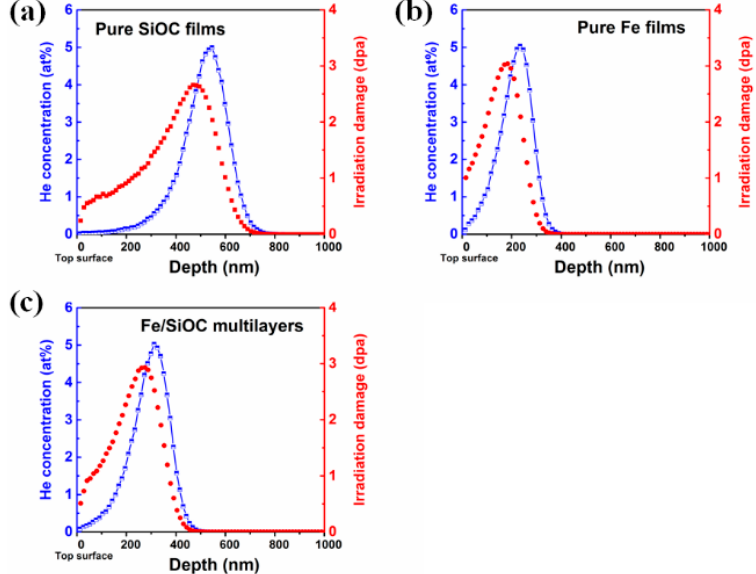
Figure 1. The simulated depth profile of radiation damage and helium concentration in ( a ) pure SiOC film, ( b ) pure Fe film and ( c ) Fe/SiOC multilayers. The peak concentration for all films are 5 at%.